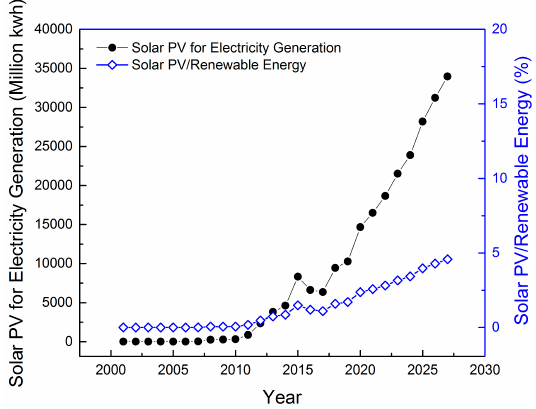
Figure 1. The OLS (Ordinal Least Squares) projection of solar PV (photovoltaics) used in electricity